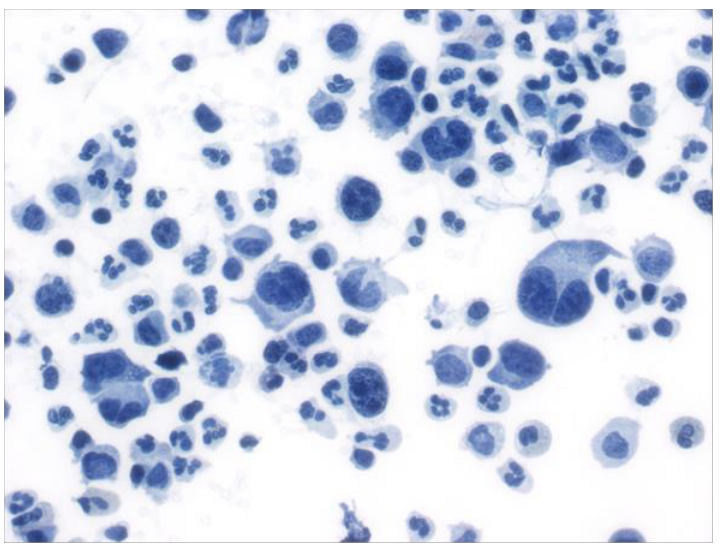
Figure 2. Cytospin from a cardiac failure patient with a fluid overload-associated large B-cell lymphoma. The patient underwent thoracentesis, the cardiac issues were treated but they did not receive treatment for the lymphoma. One year later the patient has no evidence of disease. Notice the pleomorphic large cells, which resemble PEL cells, admixed with a number of small mixed inflammatory cells (Papanicolaou stain, 60× original magnification).